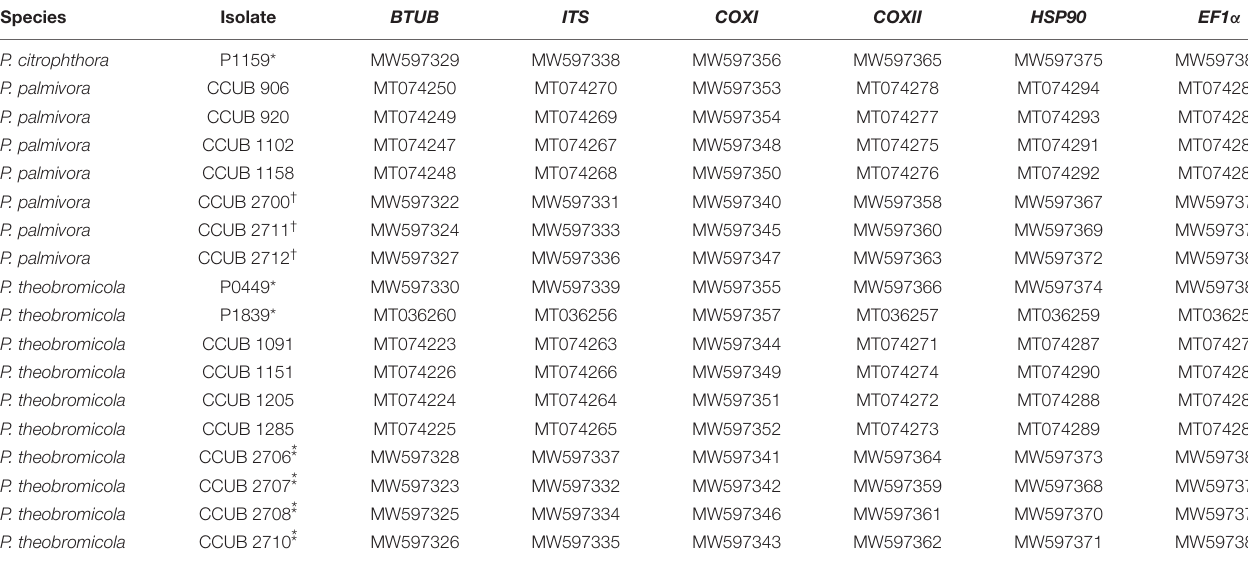
TABLE 1 | GenBank accession numbers of DNA sequences of Phytophthora isolates obtained in this study and included in the multigenic analysis. Species Isolate BTUB ITS COXI